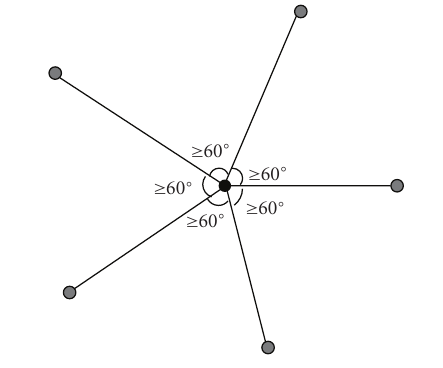
Figure 4: Constraint edges selection.